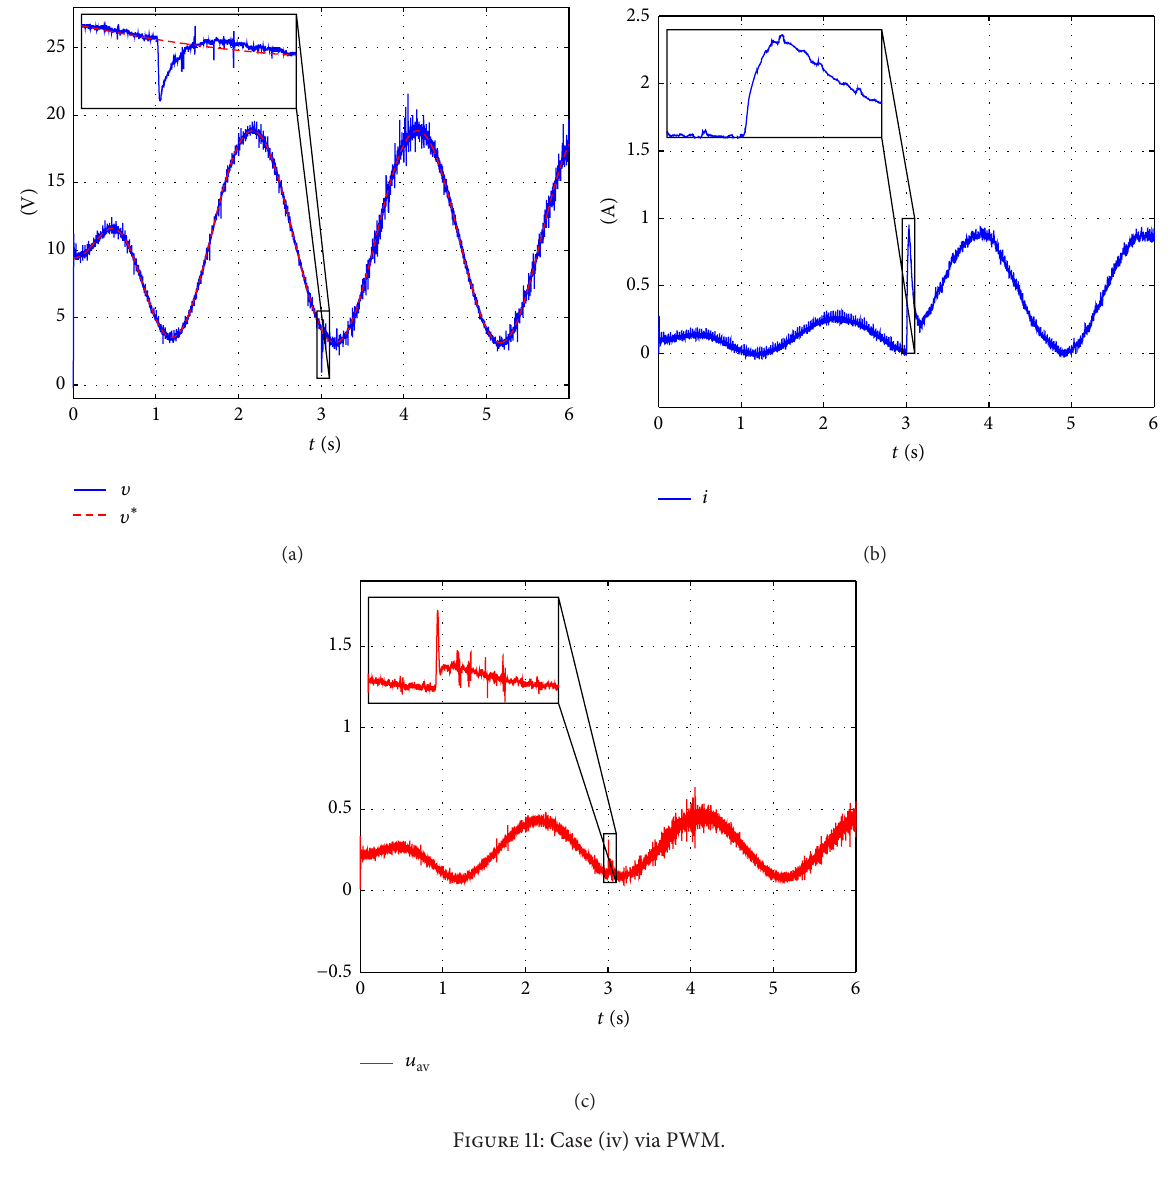
Figure 11: Case (iv) via